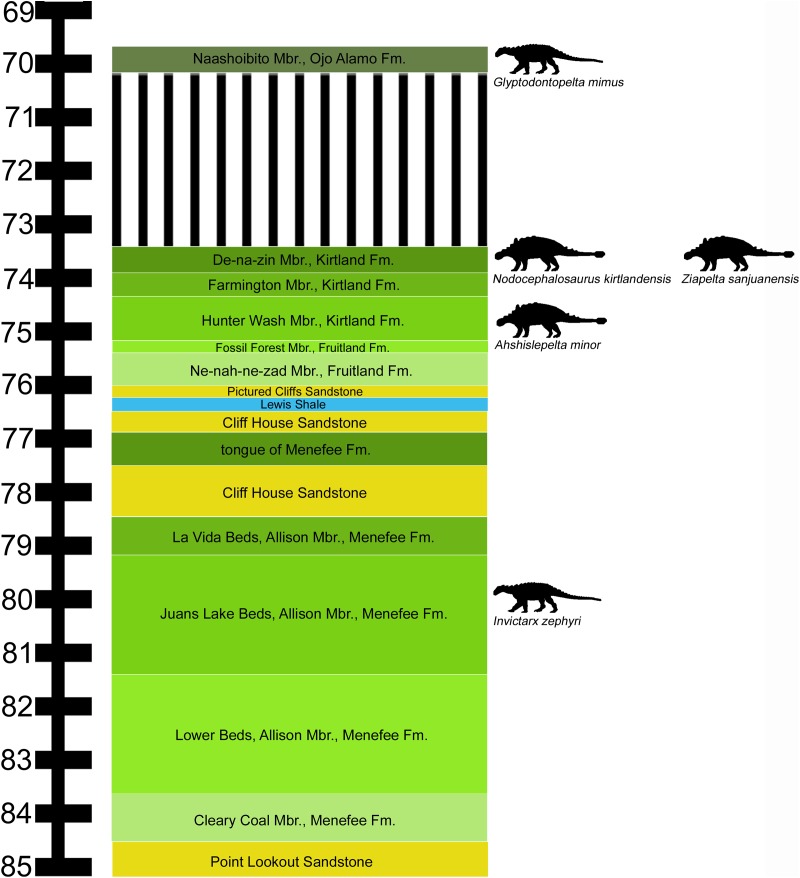
Stratigraphic occurrences of Invictarx zephyri and other ankylosaurs from the San Juan Basin.Generalized stratigraphic column of Upper Cretaceous strata in the San Juan Basin, northwestern New Mexico, showing the stratigraphic positions of the nodosaurids I. zephyri and Glyptodontopelta mimus and the ankylosaurids Ahshislepelta minor, Nodocephalosaurus kirtlandensis, and Ziapelta sanjuanensis. Ankylosaur occurrence data are from Sullivan & Lucas (2015). Nodosaurid silhouette by Scott Hartman (https://creativecommons.org/publicdomain/zero/1.0/), and ankylosaurid silhouette by Andrew A. Farke (https://creativecommons.org/licenses/by/3.0/), both available from PhyloPic. Stratigraphic column is derived from data in Miller, Carey & Thompson-Rizer (1991), Molenaar et al. (2002), Sullivan & Lucas (2006), and Fowler (2017).